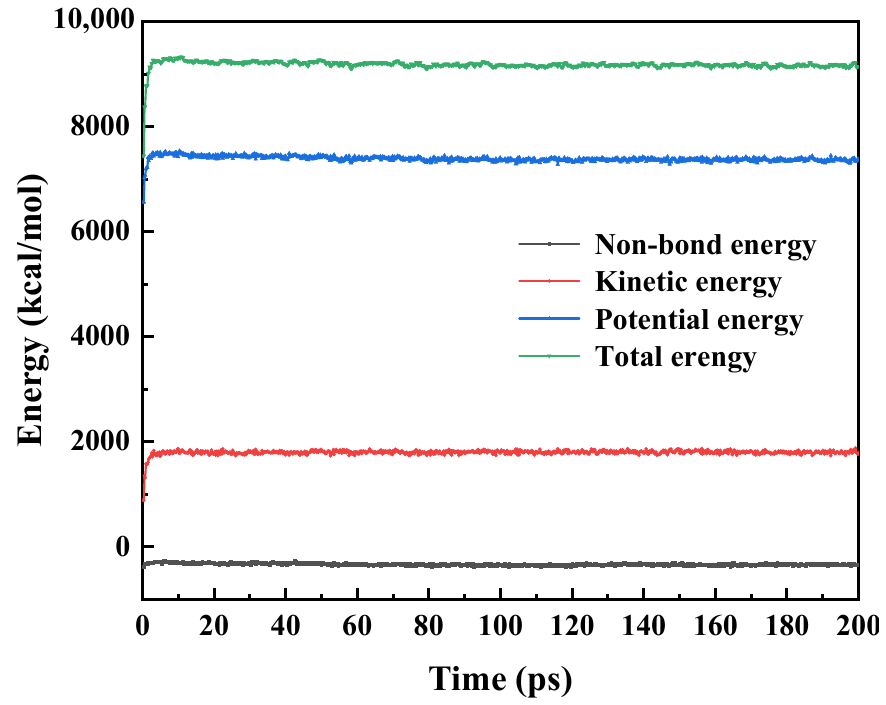
Figure 3. Energy of warm mix asphalt lubricating film model during NPT equilibrium at simulation temperature of 298